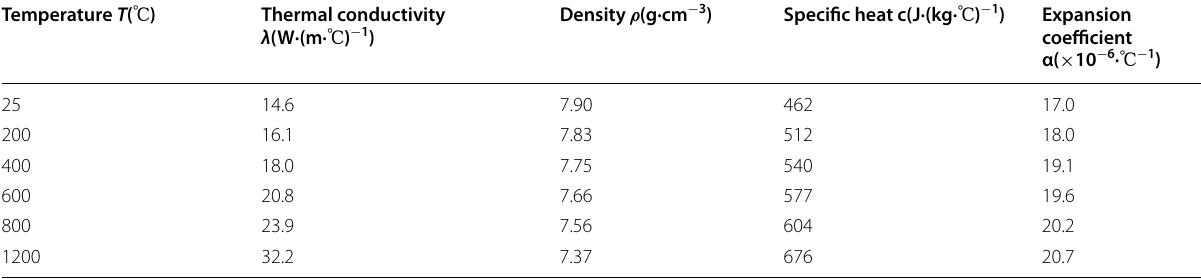
Table 1 Thermophysical parameters of the material Temperature T ( ℃ )